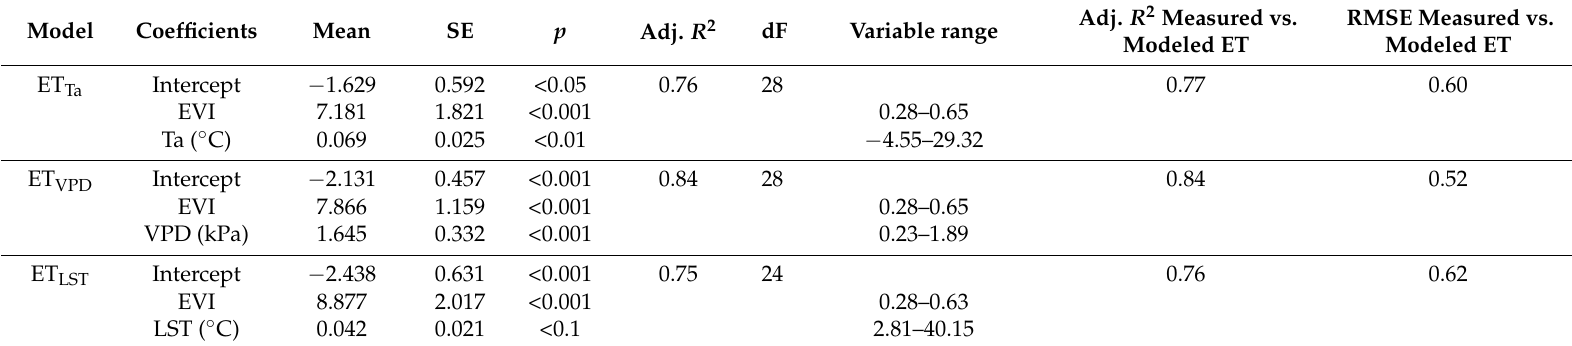
Table 3. Coefficients of a multiple linear regression analysis with EVI and Ta, VPD, or LST as independent and ET as dependent variable. The RMSE refers to ET measured with the EC station versus modeled ET within the 80% footprint